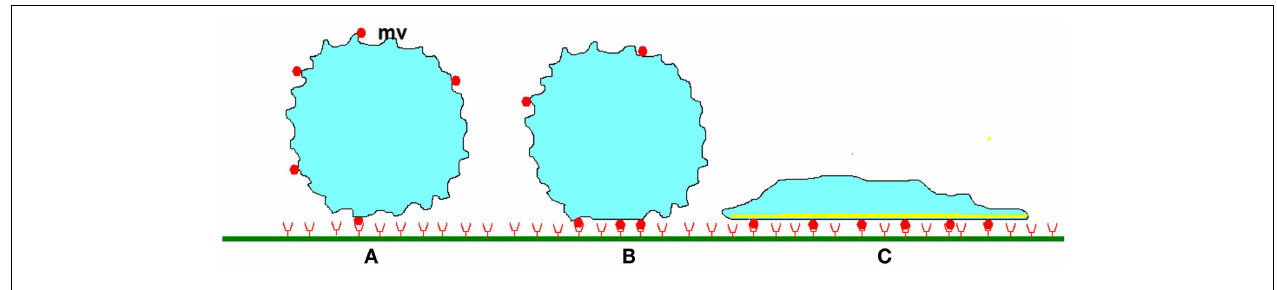
liquid droplets encountering a wettable surface, (ii) submicrometer-scale smoothing of microvilli, first due to compressive forces, and possibly later to intracellular signaling triggered by chemokines. (iii) lateral diffusion of membrane receptors that are trapped into the contact area. At some moment, these phenomena induce cell arrest. (C) Further attachment strengthening may involve a more extensive increase of contact area as a consequence of spreading, increase of membrane stiffness due to local cytoskeleton reinforcement, and possibly increase of the strength of membrane receptors attachment to underlying cytoskeleton, thus preventing further lateral